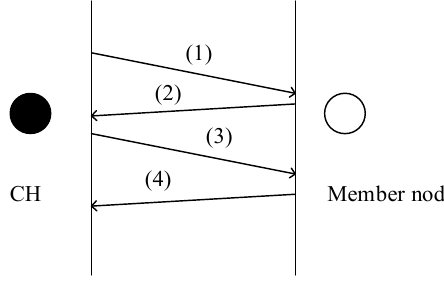
Figure 2. The interactions between the CH (cluster head) and the member node.